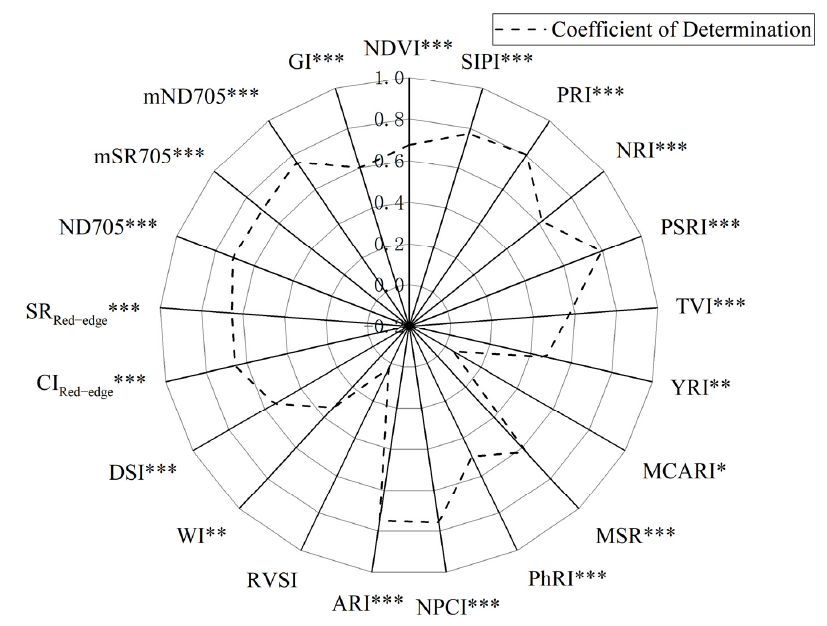
Figure 5. Determination coefficients of selected vegetation indices and strip rust disease index. Note: * indicates confidence level p < 0.05, ** indicates confidence level p < 0.01, *** indicates confidence level p < 0.001.